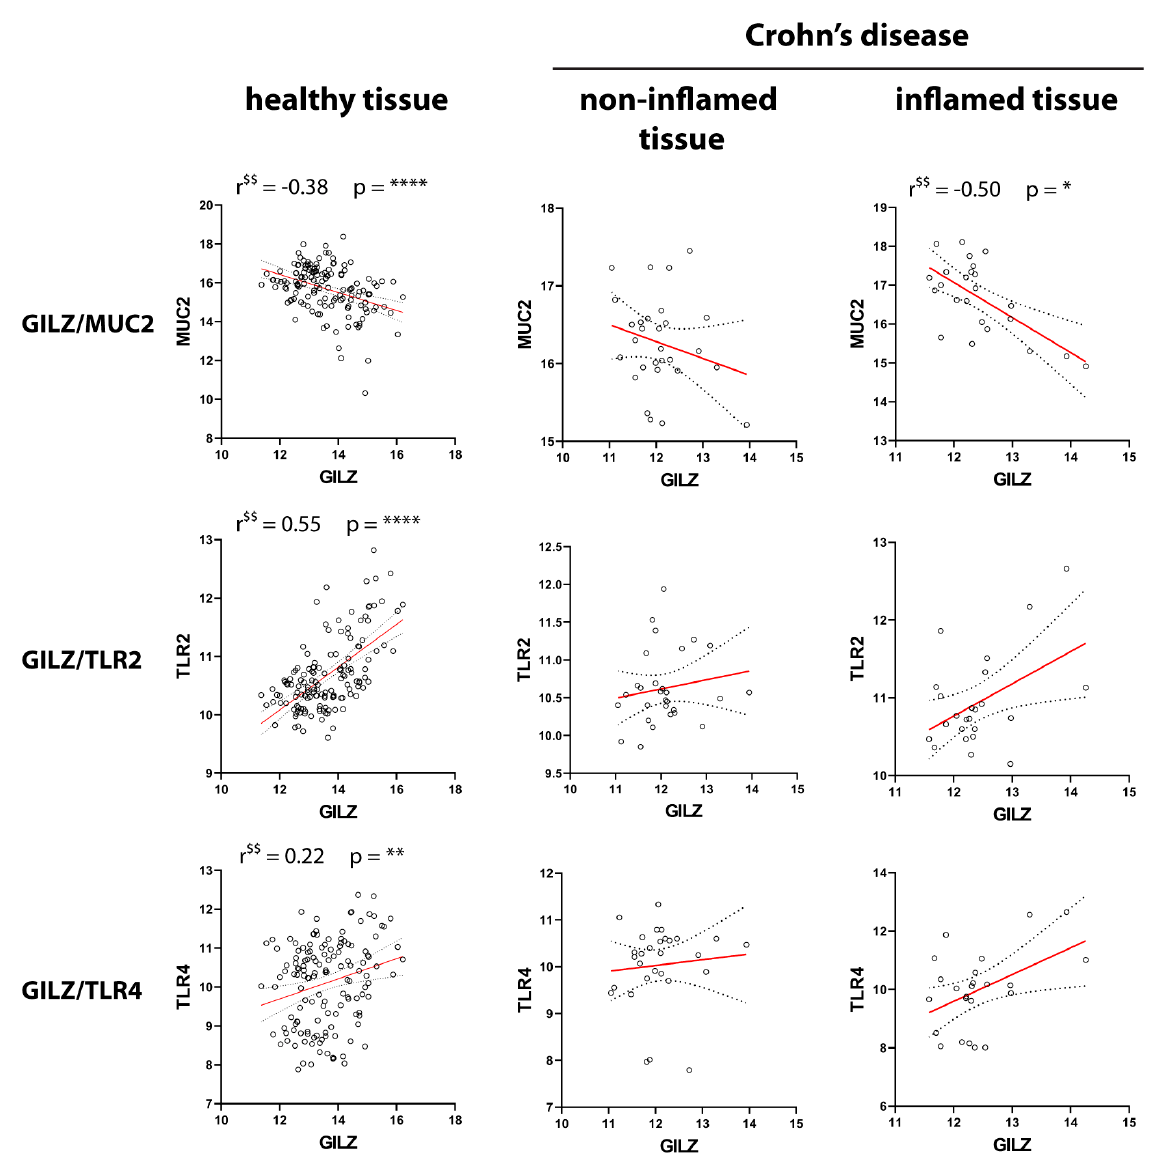
Figure 5. Pairwise correlations between GILZ , MUC2 , TLR2 , and TLR4 in healthy and UC tissues. Correlations between the expressions of the four genes in healthy control tissue ( left panels), non ‐ inflamed tissue ( middle panels), and inflamed tissue ( right panels) from UC patients are shown. $: significant according to Pearson’s correlation analysis; $$: significant according to Spearman’s cor ‐ relation analysis. p ‐ values <0.05 were considered statistically significant; p < 0.05 = *; p < 0.01 = **; p < 0.001 = ***; p < 0.0001 = ****. Non ‐ significant correlations ( p > 0.05) were not reported.